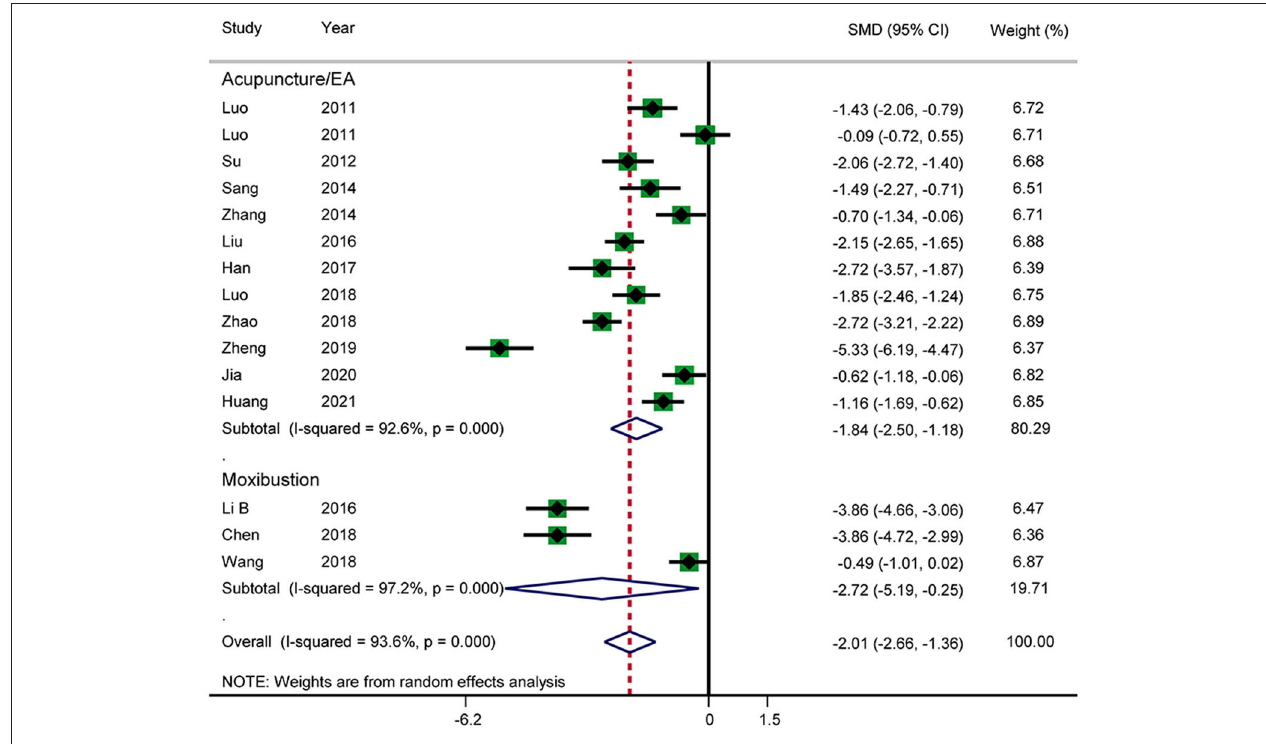
FIGURE 9 | Meta-analysis of time until first defecation.